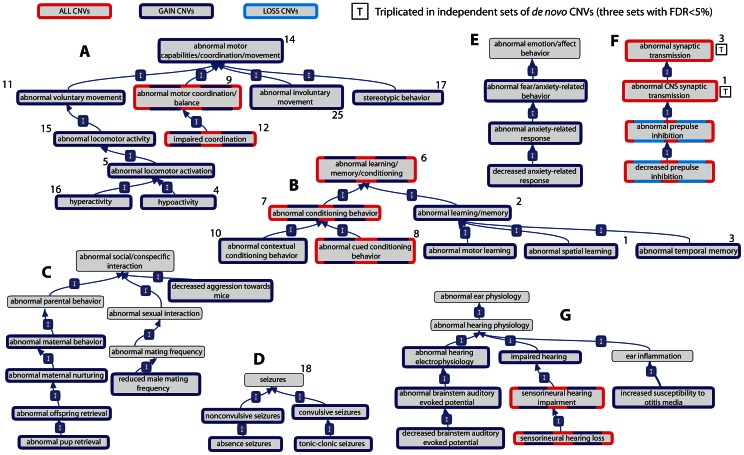
Relationships of mouse model phenotypic terms enriched among genes overlapped by de novo CNVs identified in individuals with ASD.Relationships between phenotypic terms within the Mammalian Phenotype Ontology are indicated by a blue arrow running from the child term to the parent term. Terms are significant (BH-adjusted p<5%) in at least one of 4 sets of de novo CNVs identified in individuals with autism if they are shown with a coloured border (red, dark and light blue). Those terms whose significant enrichment is observed in three independent sets, and thus triplicated, are marked with a boxed letter “T”. Panels A–E show representative clusters of Behaviour/Neurological phenotypic category, while Panel F shows the enriched phenotypes from the Nervous System phenotypic category and Panel G shows representative enrichments from the Hearing/Vestibular/Ear phenotypic category. The number adjacent to the phenotypic terms indicates the rank of that phenotypic term among those phenotypes significantly enriched among a set of 22 disease genes previously implicated in ASD (see Results).